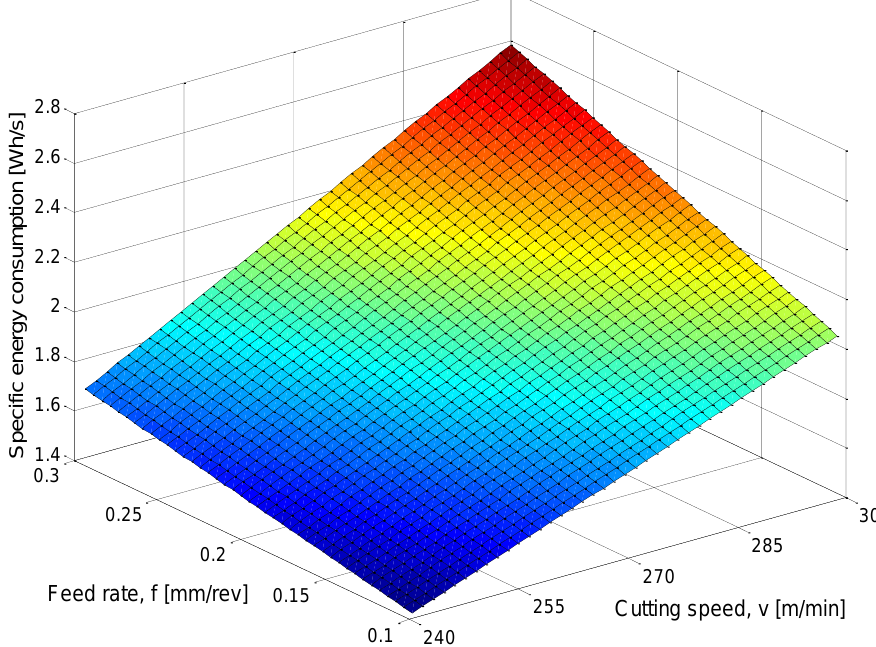
Figure 15. Change in STEC with respect to feed rate and cutting speed.